Question: Provide a one-line summary of what is displayed.
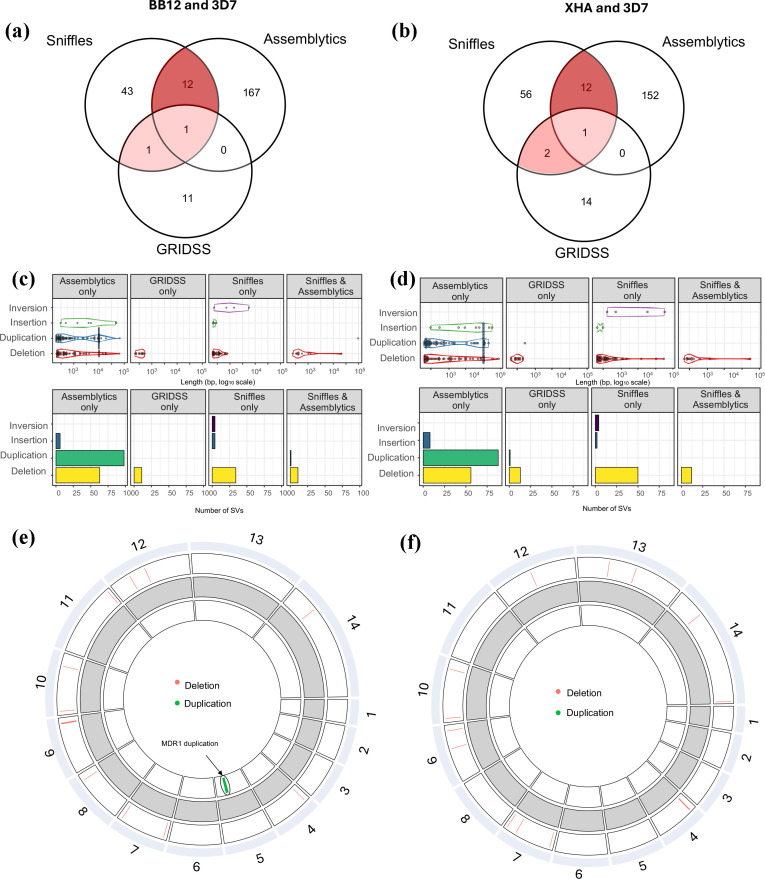
Answer: Comparison of SV calling pipelines using long reads only (Sniffles), short reads only (GRIDSS) and our de novo assemblies (Assemblytics). Overlaps in the sets of high-quality SVs identified by each pipeline, BB12 and XHA, are shown in ( a ) and ( b ), respectively, with red intensity indicating the number of overlaps. SVs identified by different pipelines are considered equivalent if they overlap by at least 1 bp, correspond to the same SV class and have similar lengths (i.e. the length of the shorter SV is at least 75% of that of the longer SV) (Text S8). Sniffles (which uses long reads only) and Assemblytics (which is informed by our de novo assemblies) show a reasonable number of concordances, while GRIDSS (which uses short reads only) exhibits very little concordance with either Sniffles or Assemblytics. SV types and lengths for BB12 and XHA are shown in ( c ) and ( d ), respectively. SV length and type distributions are generally quite similar for Sniffles and Assemblytics. For each panel, SVs are stratified into four categories: Assemblytics only, GRIDSS only, Sniffles only and SVs concordant between Sniffles and Assemblytics. Within each category, the upper violin plots show the distribution of SV lengths (x-axis: length in base pairs on a log₁₀ scale) for each SV type (deletion, duplication, insertion and inversion); the lower panel shows the total count of SVs (x-axis: number of SVs) for each SV type. SV length and type distributions are generally similar between Sniffles and Assemblytics. Genome-wide SV maps relative to 3D7 reference genome, restricted to SVs concordant across Sniffles and Assemblytics, are shown for isolates BB12 ( e ) and XHA ( f ), respectively. Both Sniffles and Assemblytics detected the known MDR1 duplication in BB12.